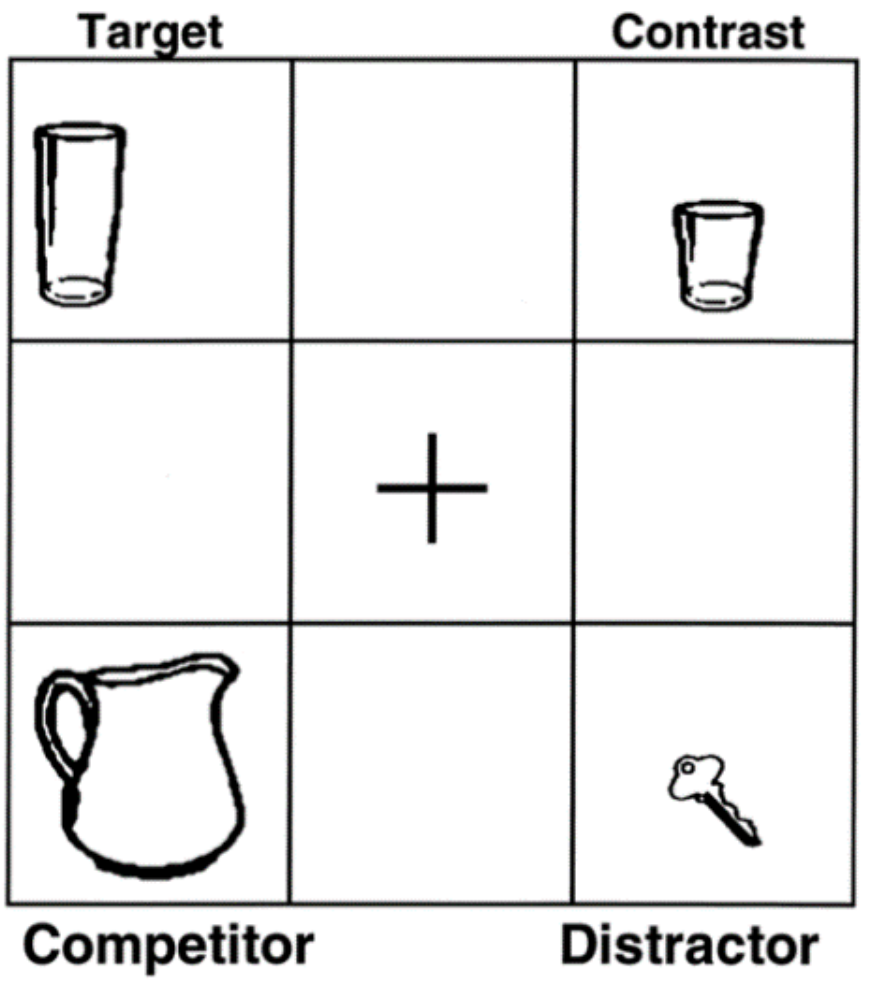
Figure 5. Example of the visual display reprinted with permission from [27]. Copyright 1999 Else- vier.